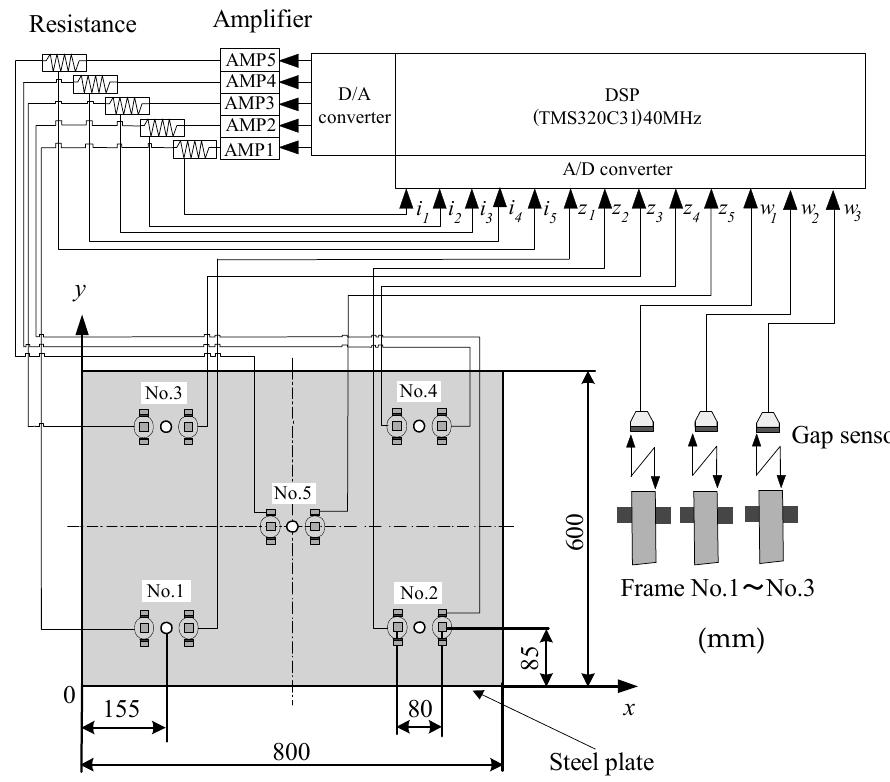
Figure 1. Electromagnetic levitation control system.